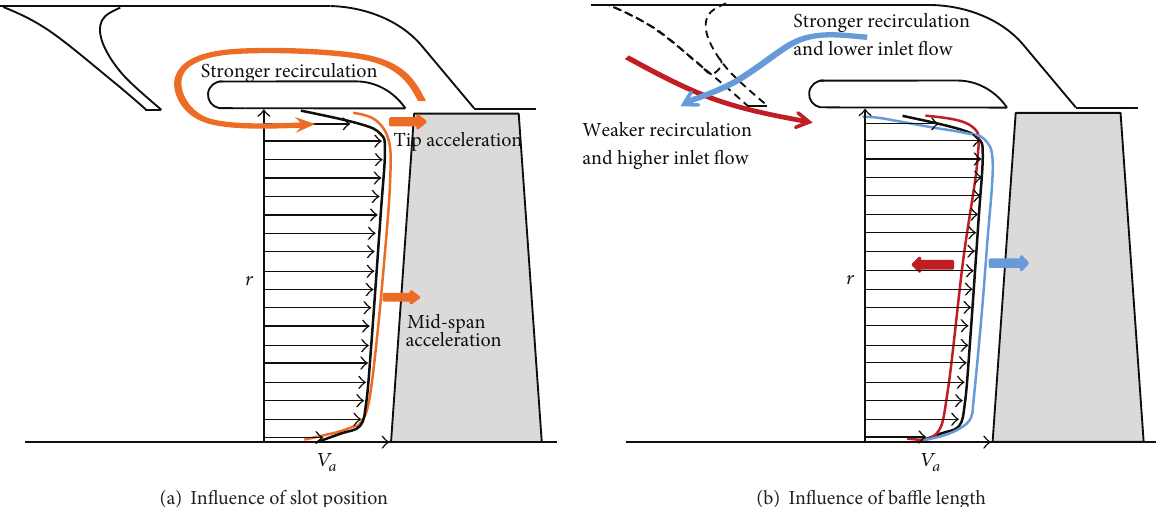
Figure 17: The influence of slot position and baffle length on the distribution of inlet velocity.